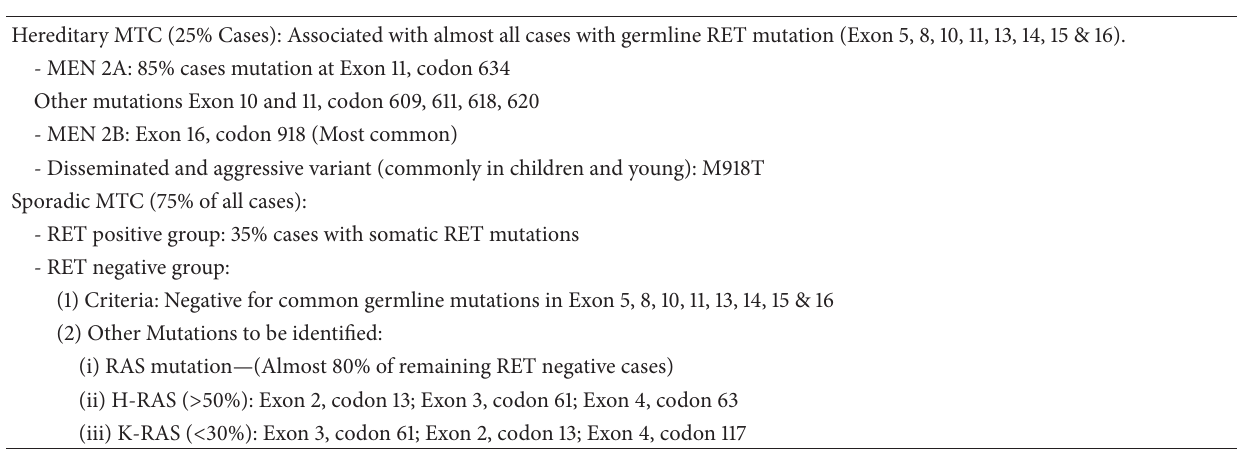
Table2:MolecularclassificationofMCT(Modifiedfrom2012EuropenthyroidcancerassociationguidelinesandwithworkdonebyBoichard et al.